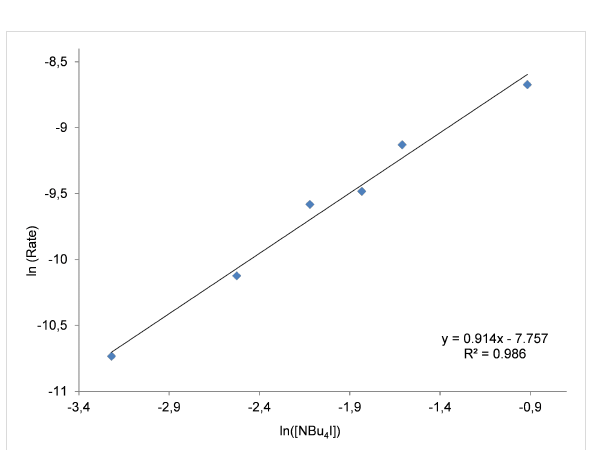
were carried out using similar reaction conditions (30 °C,